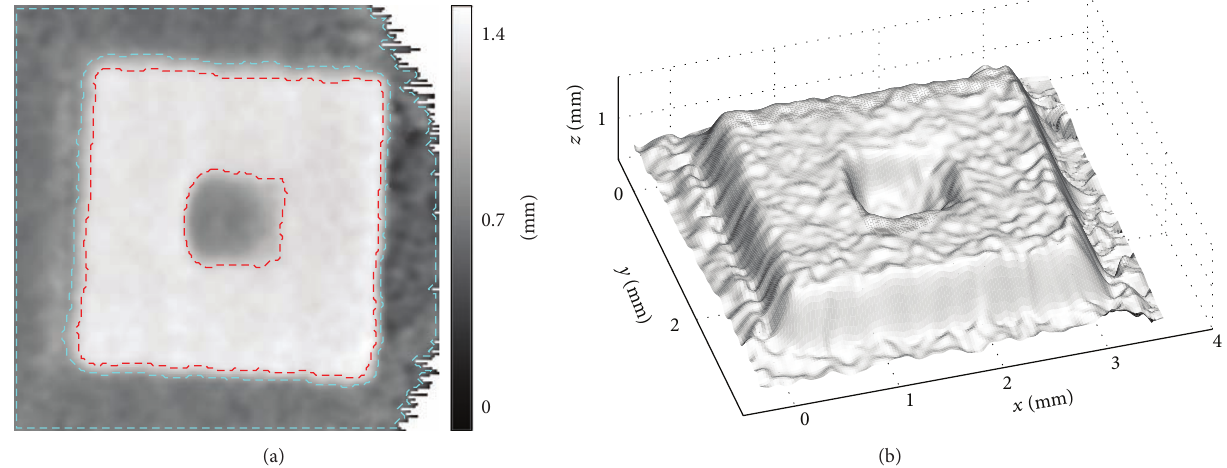
Figure 10: Open-space experiment. (a) Surface height map in 2D and (b) surface profile in 3D of the MEMS component.